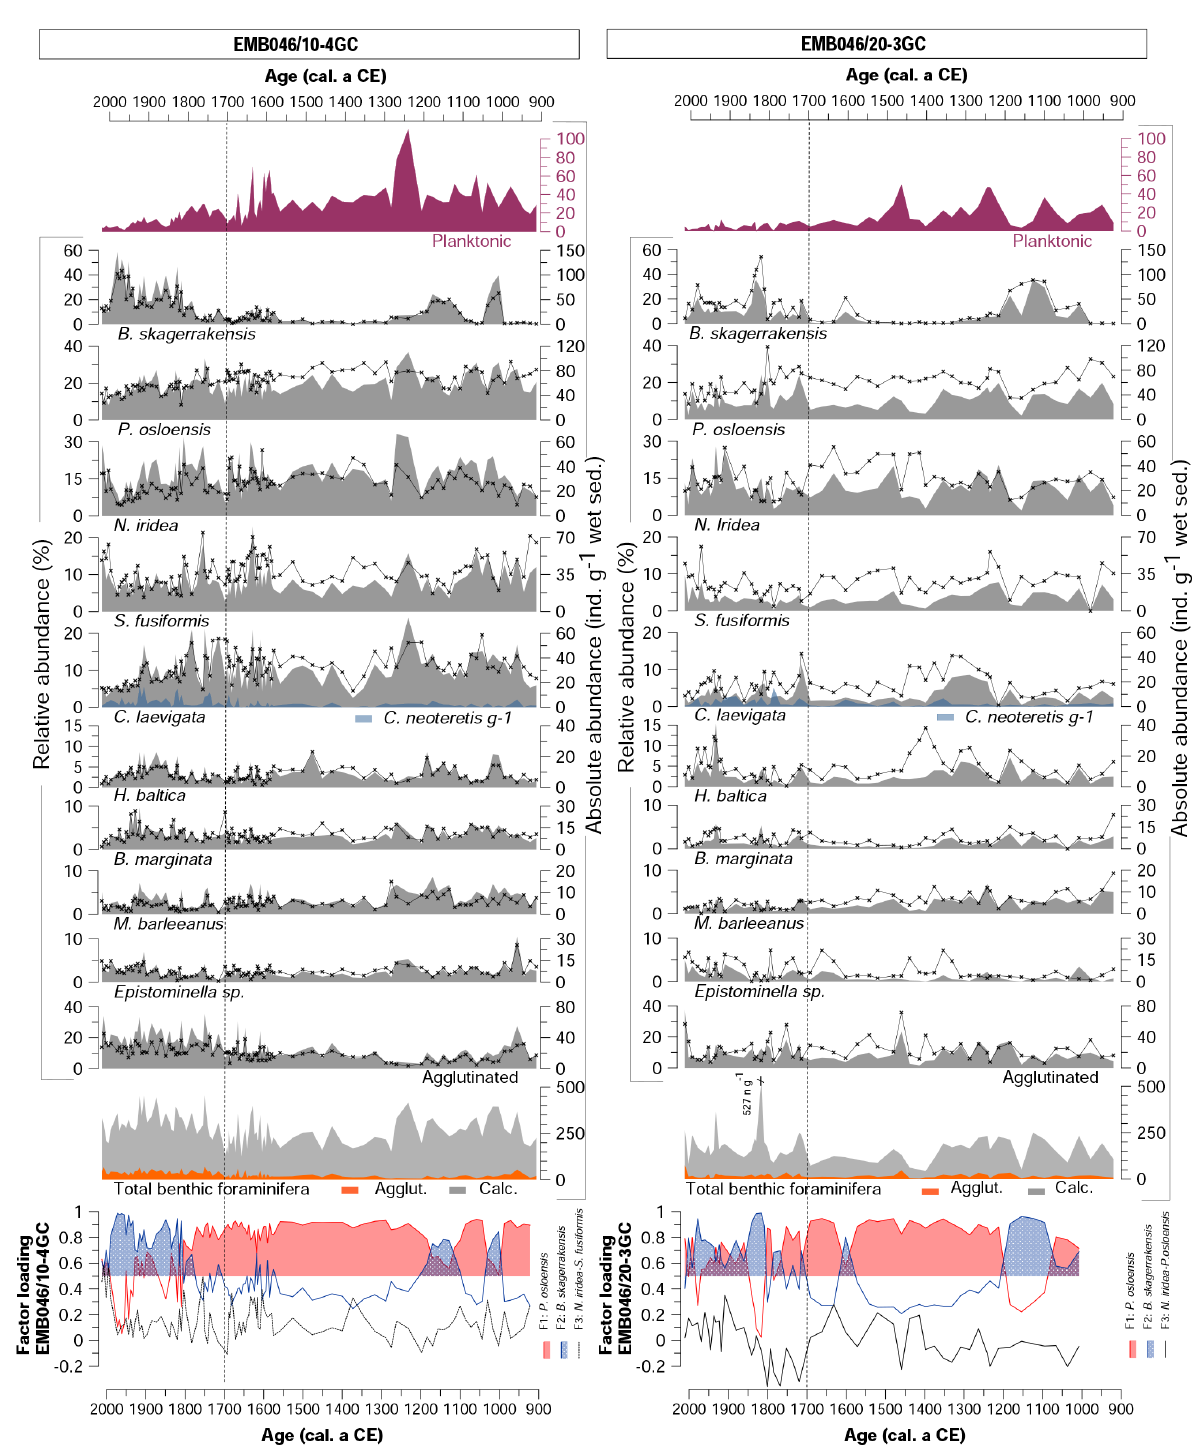
Figure 3. Foraminiferal assemblages including dominant and accessory benthic species for both cores (EMB046/10-4GC and EMB046/20- 3GC) and CABFAC results. Absolute abundance is shown as grey shading, while relative abundance as black curve with symbols. The absolute abundance of total benthic foraminifera is a sum of all species: agglutinated (Agglut.) and calcareous (Calc.). The dashed line divides record into two periods of the most pronounced palaeoproductivity changes, which are discussed in the